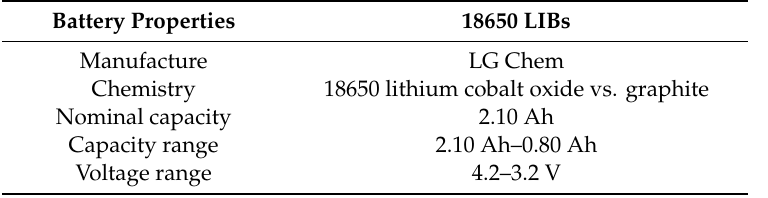
Table 1. The general characteristics of the tested cells.